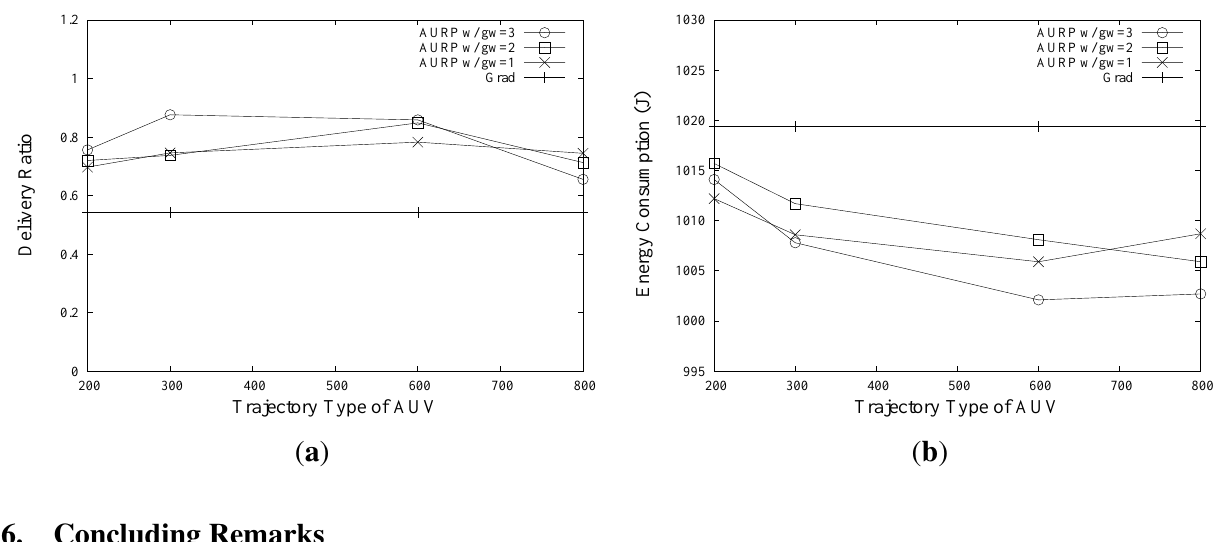
Figure 8. Effects of AUV Trajectories on the network